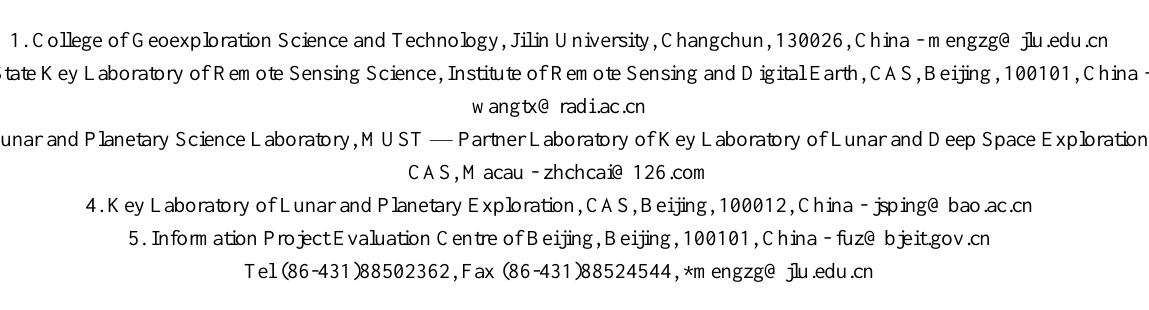
units inner and surrounding of Crisium basin using LRO imagery, Clementine maps of Fe and Ti and LOLA maps, which showed much different from that outlined by Head et al. (1978).